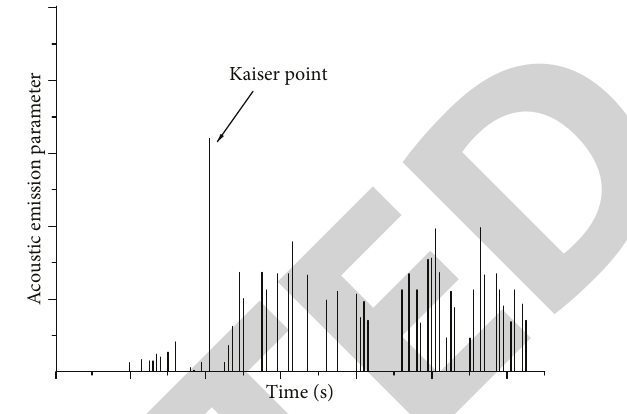
Figure 1: Kaiser point interpretation of acoustic emission